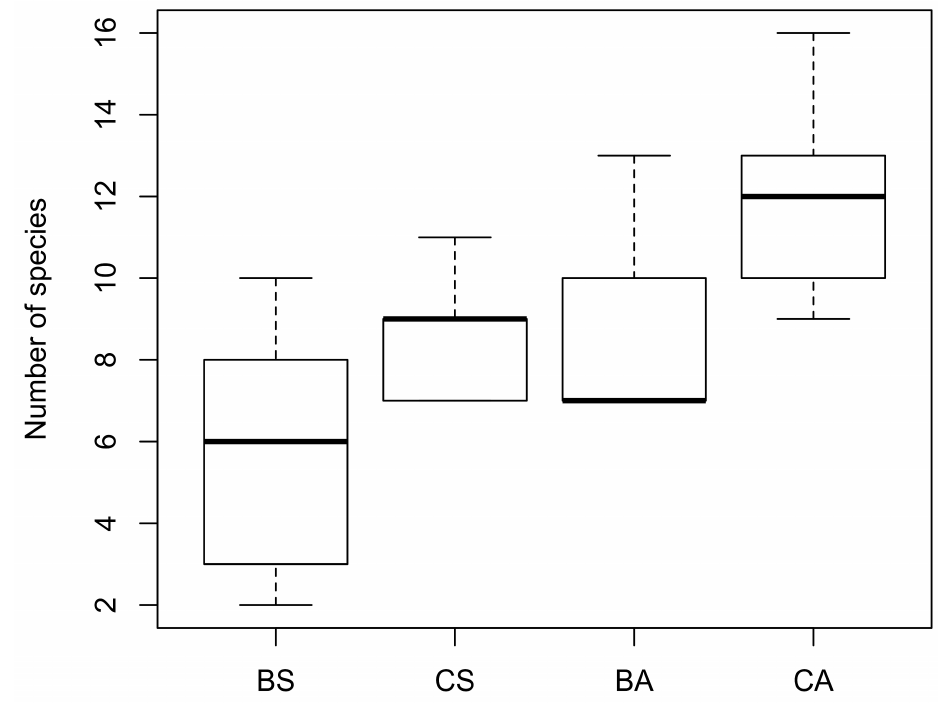
Figure 4. Average number of species per sample in the control and bioturbated plots in spring and autumn. BS, bioturbation plots—spring; CS, control plots—spring; BA, bioturbation plots—autumn; CA, control plots—autumn.